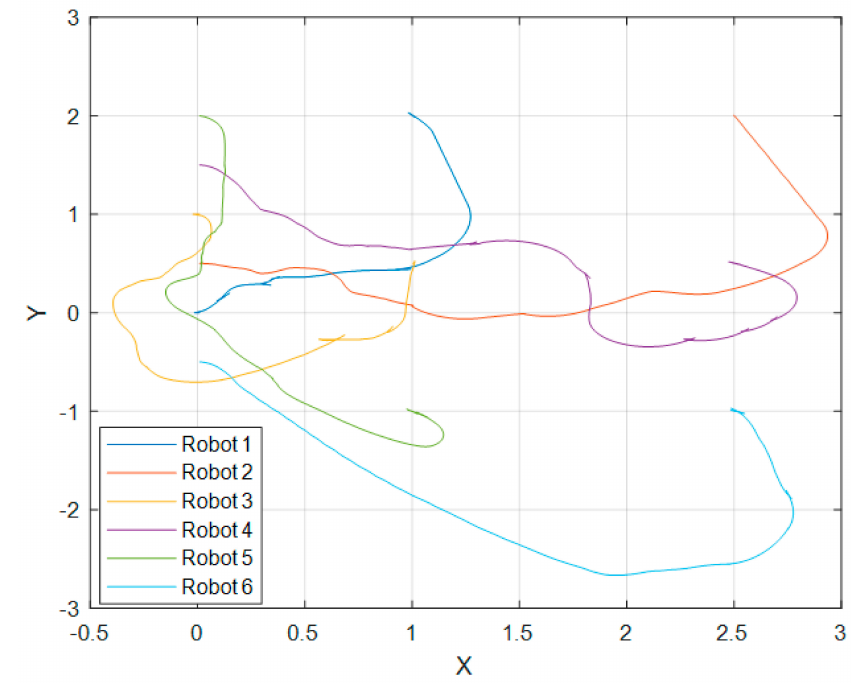
Figure 19. Trajectories in the 6-robot real-world test. Real test values x hi , y hi , v i , and ω i are plotted in Figures 20 and